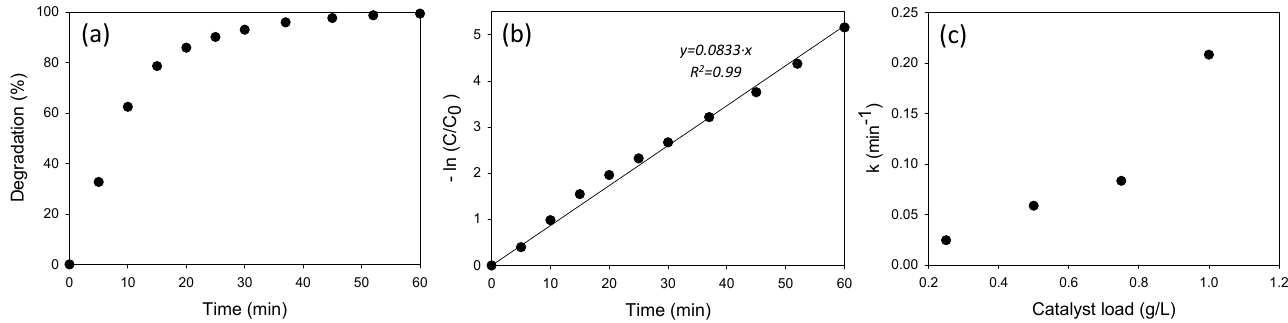
Figure 15. Kinetic studies of photocatalytic degradation of ATL: ( a ) Degradation with time (10 ppm ATL and 0.75 g·L − 1 of AgCl). ( b ) Fit to a pseudo-first-order reaction. ( c ) Pseudo-first-order coefficients as a function of nanocatalyst load.